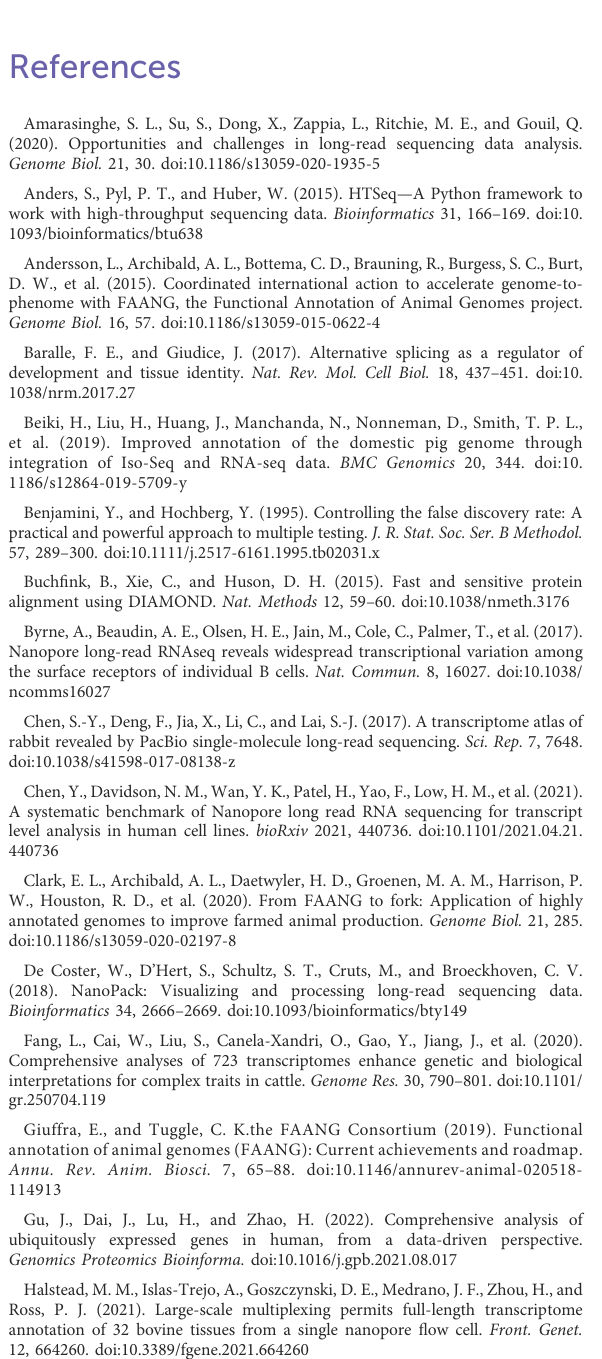
SUPPLEMENTARY TABLE S6 Functional enrichment of tissue-speci fi c transcripts (only Biological Process of Gene Ontology terms). SUPPLEMENTARY TABLE S7 Number of unique transcripts detected when adding more tissues.